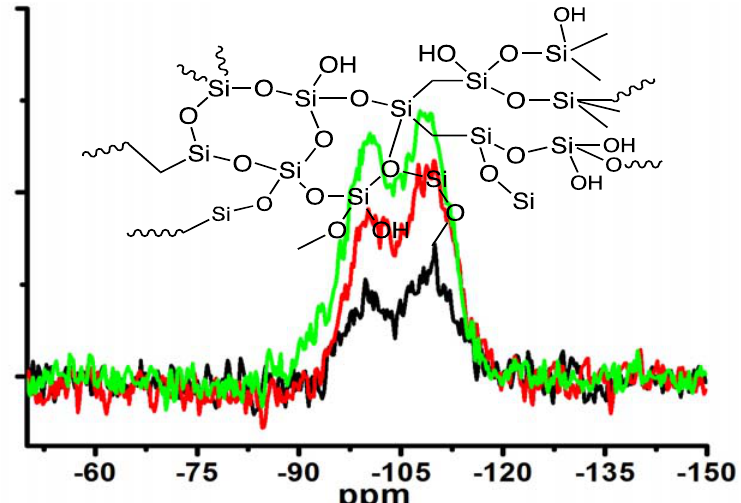
Figure 5. 29 Si CPMAS NMR spectra of the samples under different concentrations of = 10 g). Insert: schematic description of MS-51 by fixing 10 wt % LPEI in Process-II ( m ice amorphous silica. Black line: 10 vol % MS-51; Red line: 20 vol % MS-51; Green line: 30 vol %